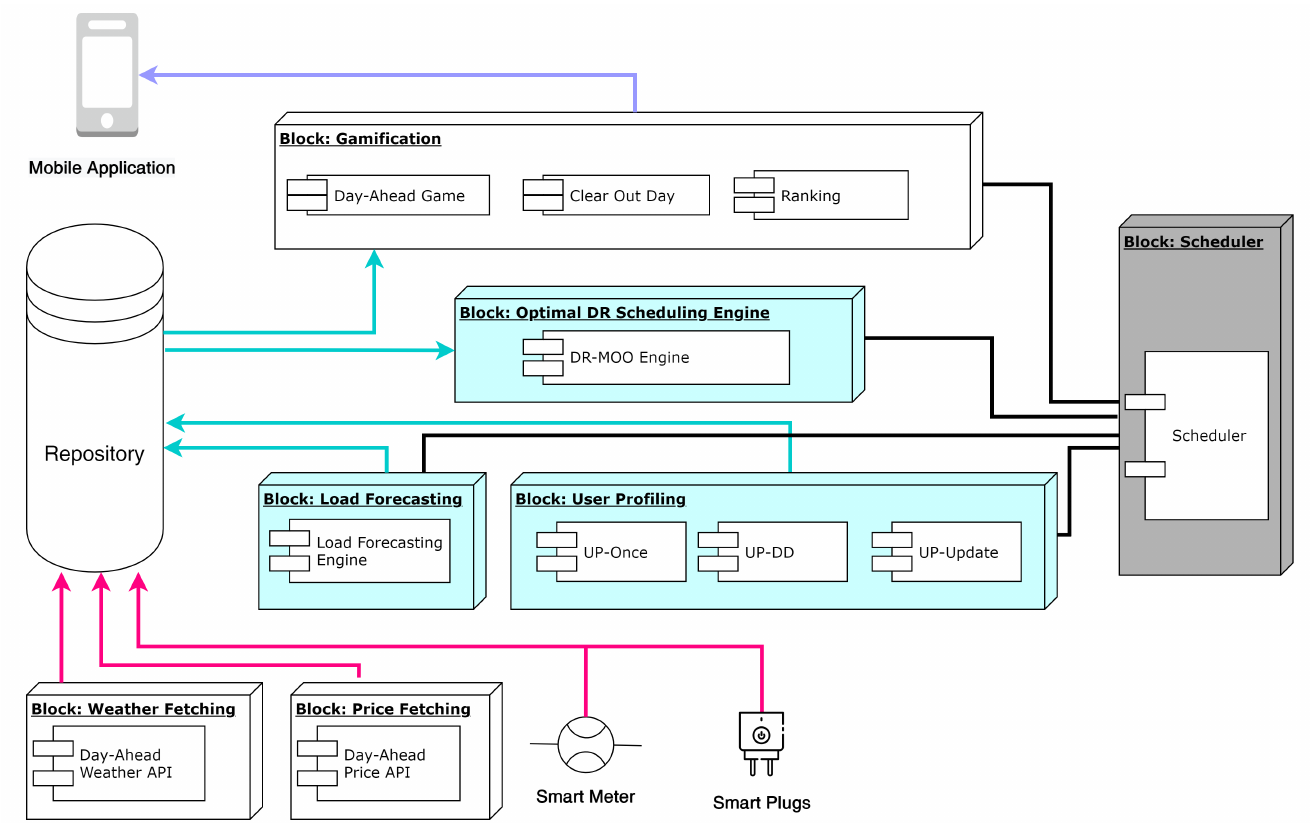
Figure 2. ODRes System Architecture